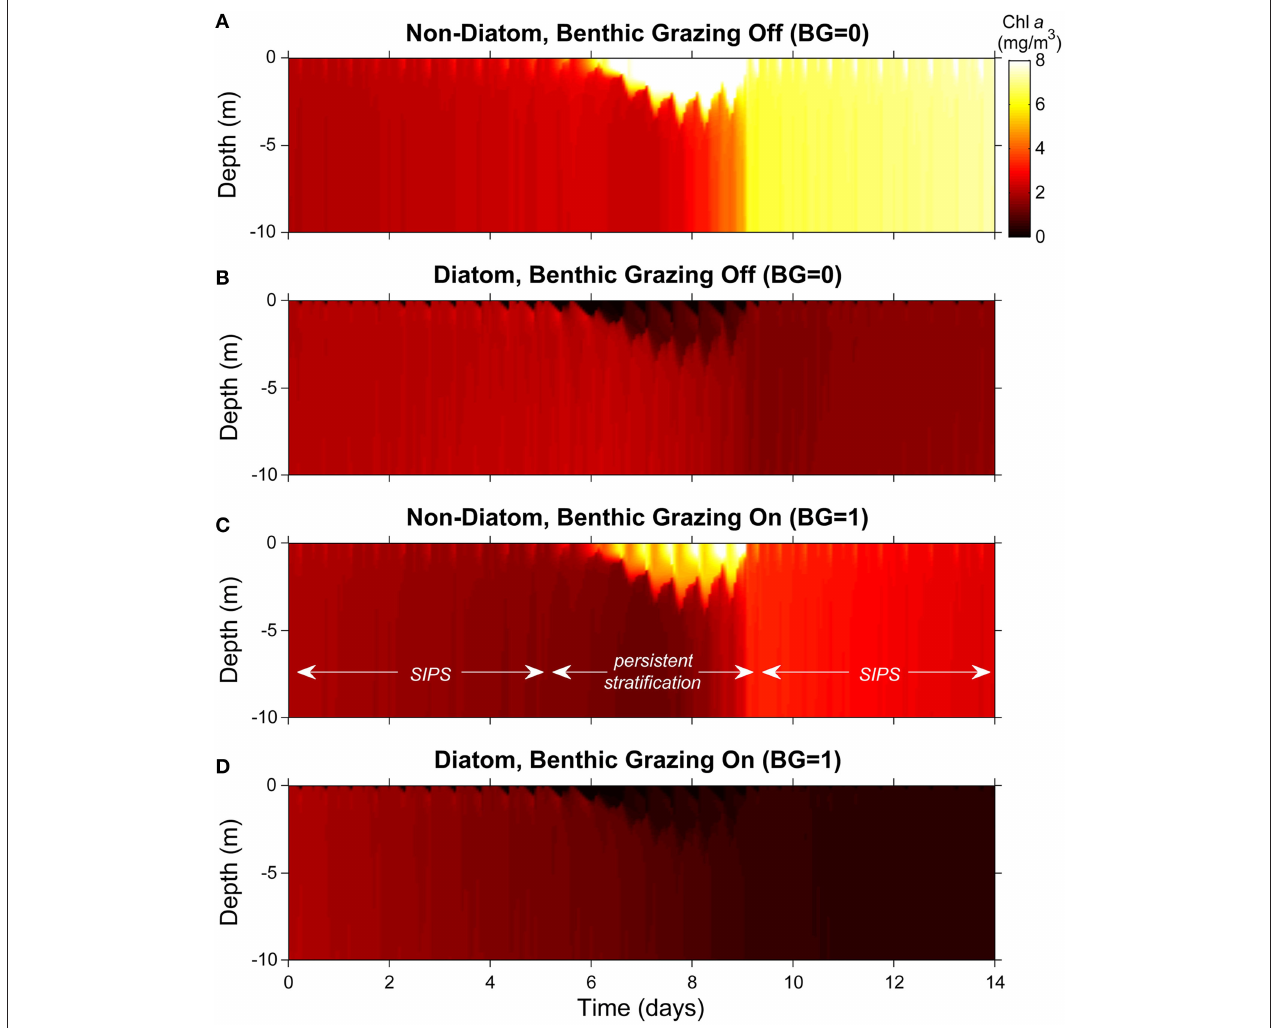
FIGURE 6 | Phytoplankton biomass color contour plots for generic channel. Images represent variability of computed phytoplankton biomass in depth (vertical) and time (horizontal). The cases shown are the same as in Figure 5C (generic channel with persistent neap-tide stratification). Diatoms and non-diatoms were differentiated by sinking speed: W s = 3 m/d for diatoms and 0m/d for non-diatoms. (A) non-diatoms with zero BG (benthic grazing rate); (B) diatoms with BG = 0m 3 /m 2 /d; (C) non-diatoms with BG = 1m 3 /m 2 /d; (D) diatoms with BG = 1m 3 /m 2 /d. Colorbar applies to all